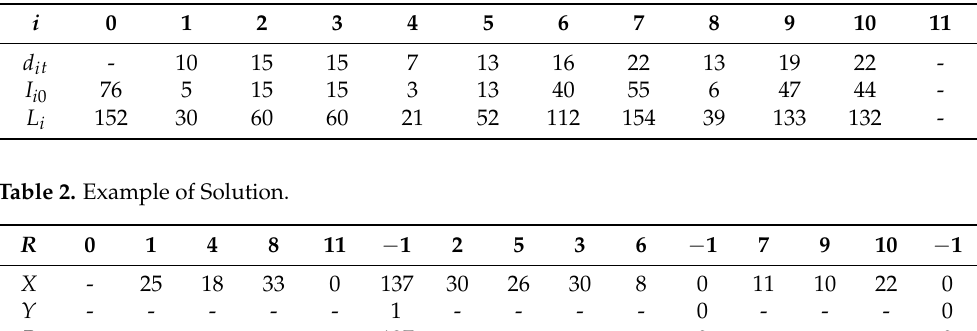
Table 1. An example of a data for ( n = 10, l = 3, m = 3).